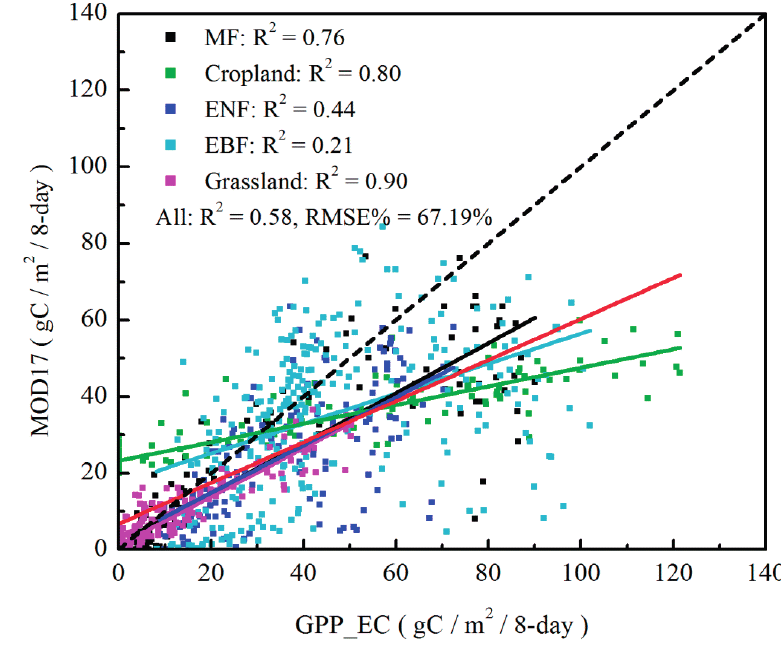
Figure 2. Relationship between the flux measured GPP (GPP_EC, X-axis) and results of MOD17 (Y-axis) for five different land cover types. The dashed line indicates 1:1 line. The red solid line indicates a linear trend for all